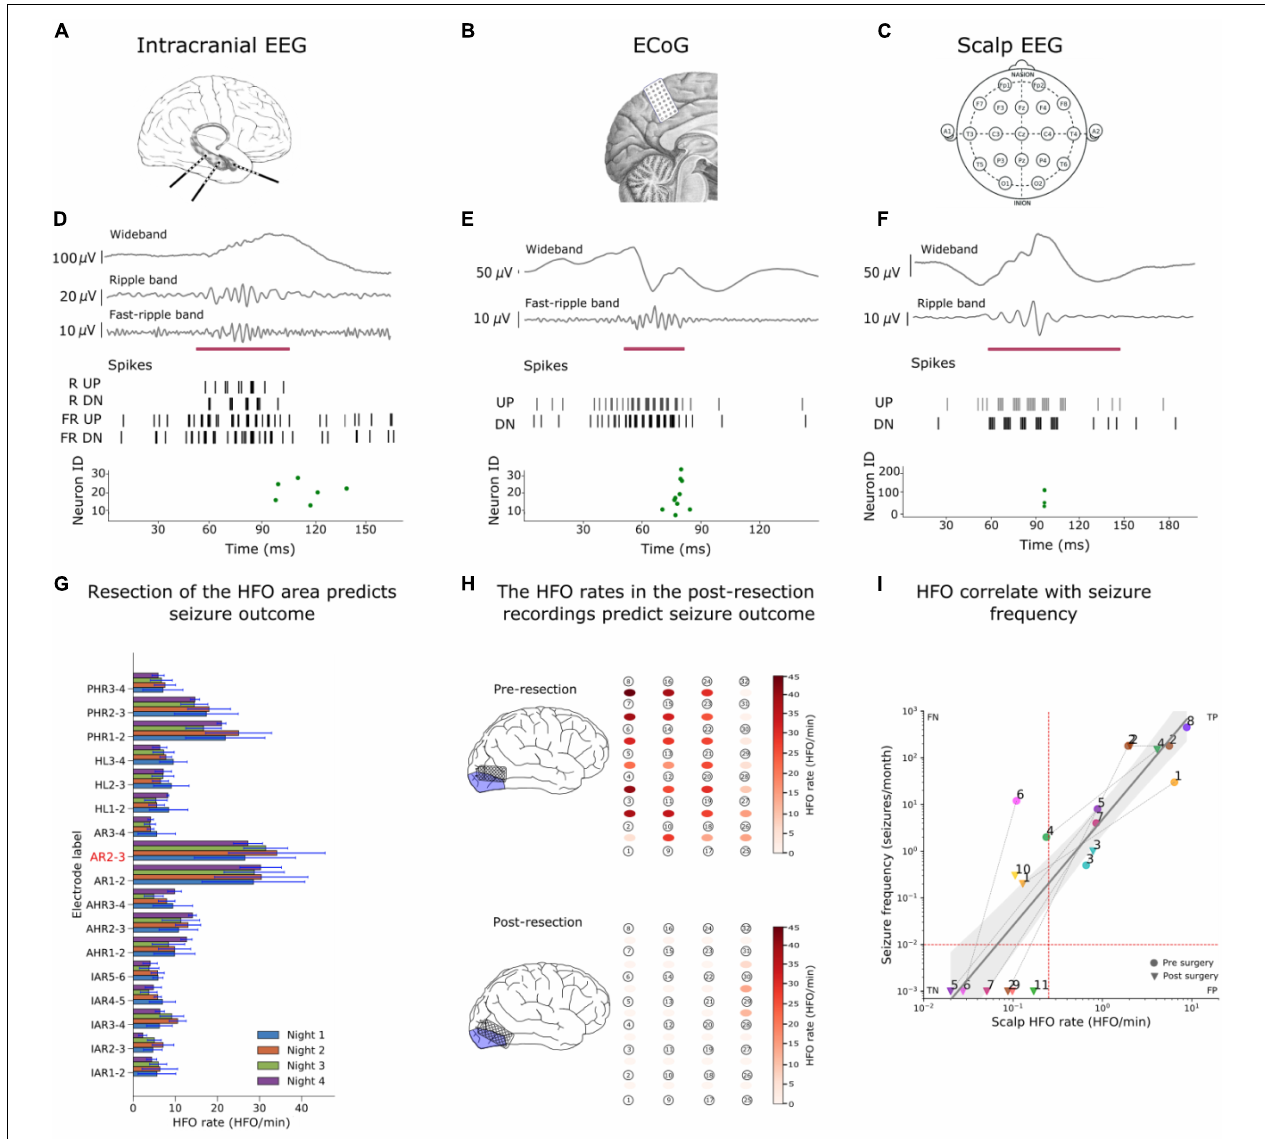
FIGURE 3 | Examples of HFO detection in iEEG, ECoG and scalp EEG. (A–C) We detected HFO in three recording modalities. (A) We analyzed iEEG recordings from a patient with temporal lobe epilepsy (TLE) who was implanted with depth electrodes, (B) the ECoG from a patient whose surgery was guided using ECoG electrodes and ( c ) a scalp EEG from a child with drug-resistant focal lesional epilepsy. [ (D–F) upper panels] The wideband signal was filtered in HFO bands [ (D–F) upper panels], The filtered signals were converted into spikes [ (D–F) middle panel] and sent as input to the SNNs. The green dots of the raster plots [ (D–F) bottom panels] show the activity of the second layer neurons indicating the presence of an HFO in the signal, and the purple mark shows the time window that our detector marked as HFO due to this spiking activity. (G) We used the HFO rates found in iEEG to define the HFO area (AR2-3), which was compare to the resection area to predict the seizure outcome of the patient. (H) Our SNN found a high HFO rate (HFO rate > 1 HFO/min) in the pre-resection ECoG from a patient. The SNN found a HFO rate of > 1HFO/min in a patient who suffers from recurrent seizures. Hence, our SNN predicted seizure recurrence in the individual patient. (I) The scalp HFO rate correlated with seizure frequency of our pediatric patient and mirrored the surgical treatment response. Panels modified from Burelo et al. (2021, 2022), Sharifshazileh et al.